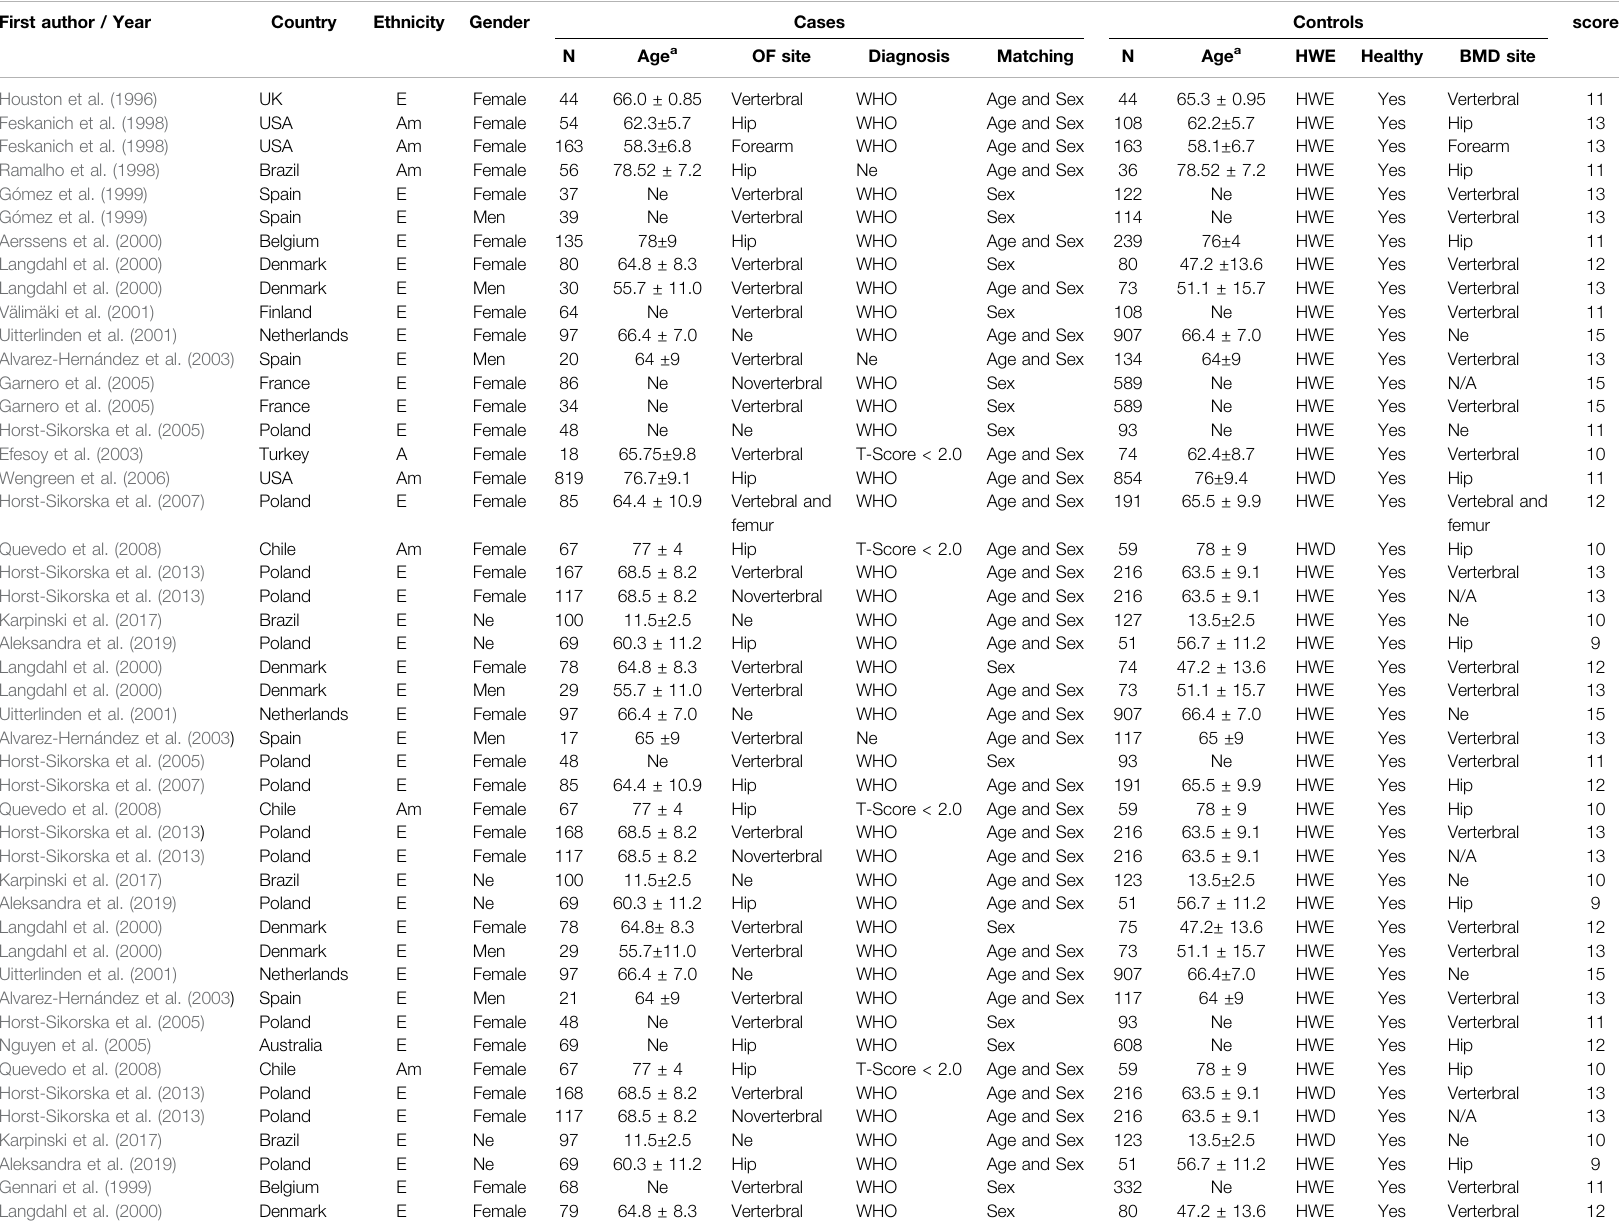
TABLE 1 | Main characteristics and Quality score of studies